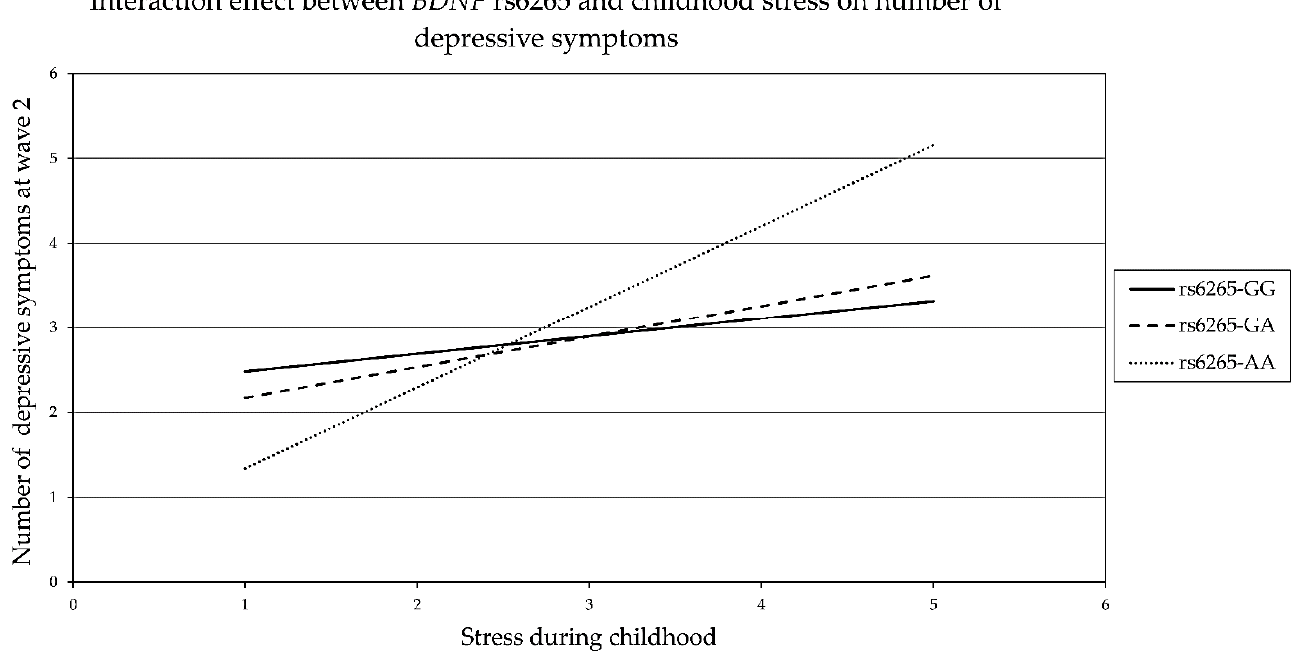
Figure 4. Interaction between BDNF rs6265 and childhood stress in wave 2 (Model 1).